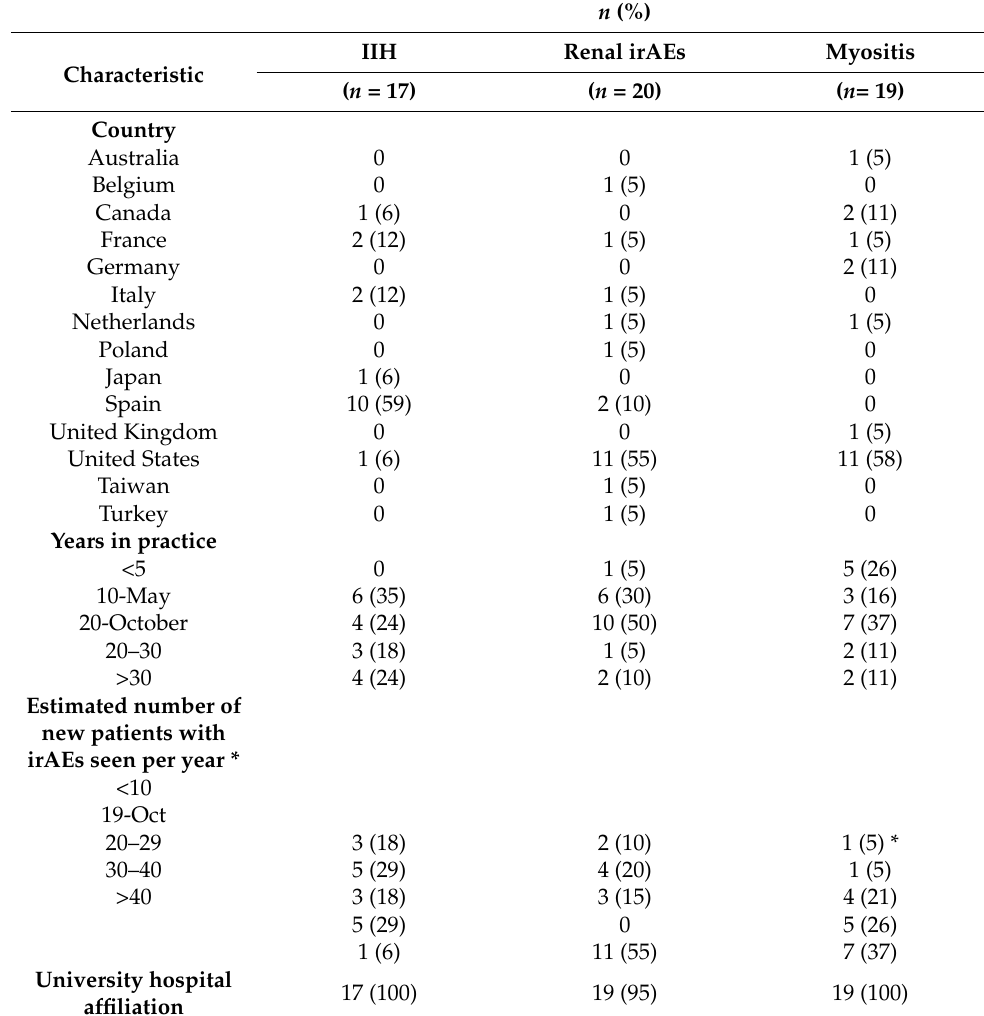
Table 1. Characteristics of the Experts Who Completed the